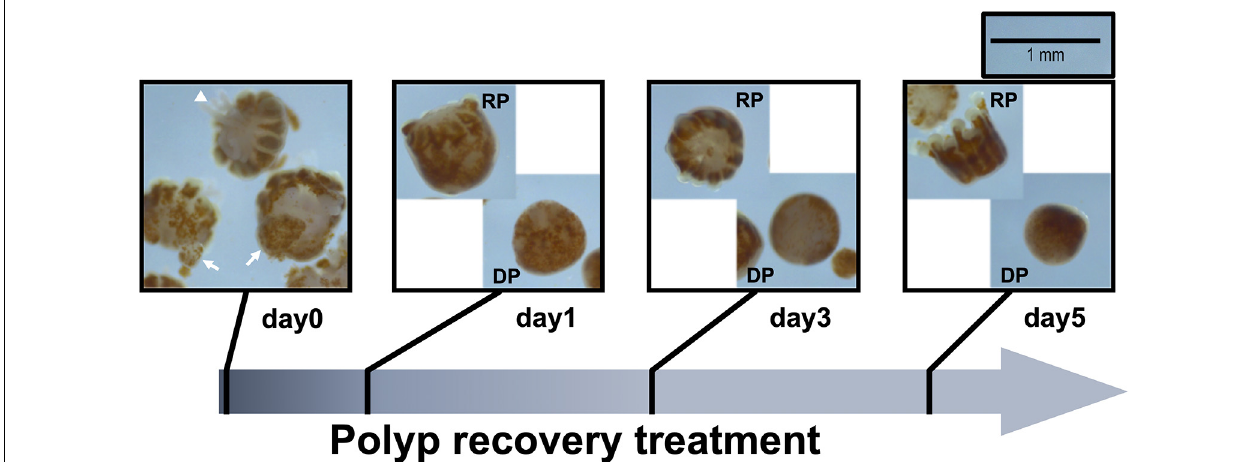
FIGURE 2 | Morphological changes of Pocillopora acuta polyps post-bail-out. Residues of coenosarc tissues (arrow) and extruding mesentery filaments (arrowhead) are observable in some polyps right after bail-out (day0). After recovery for 1 day in isosmotic conditions, polyp bodies become smooth and morphological differentiation can be seen among bailed-out polyps, with some polyps recovering typical morphological features such as tentacles and oral-aboral polarization (RP), while other polyps have degenerated into tissue balls